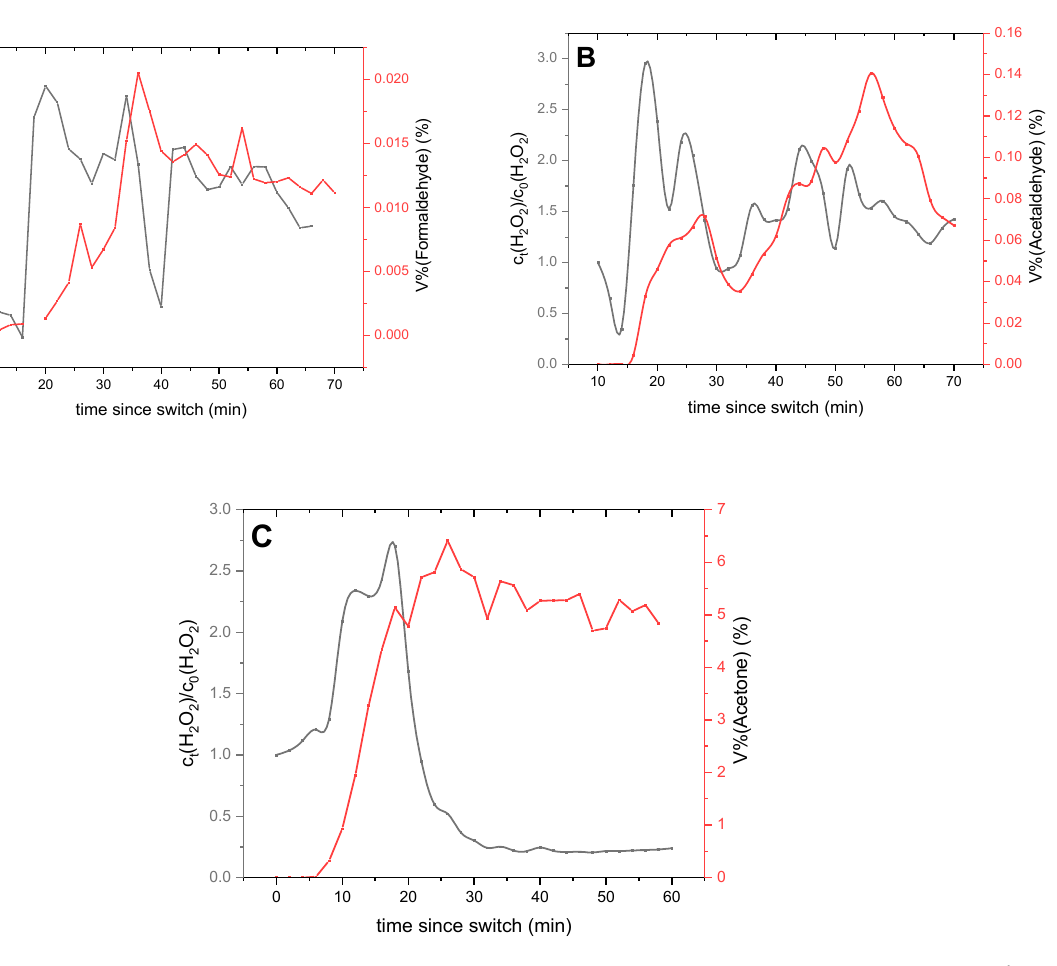
Figure 3. Relative transient response of ratio of hydrogen peroxide concentrations ( c measured and the corresponding dehydrogenation of the products of alcohol ( ϑ = 15 °C). ( A ) methanol, ( B ) ethanol, ( C ) iso-propanol.